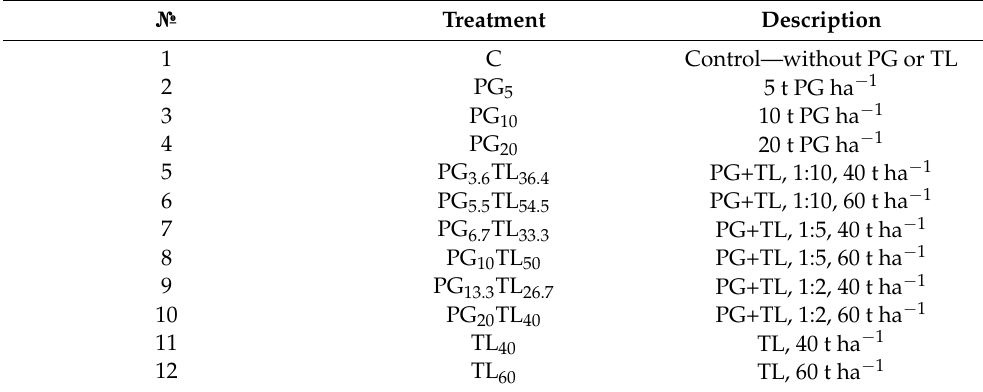
Table 2. The different treatments with PG, TL, and their combined application ratio.